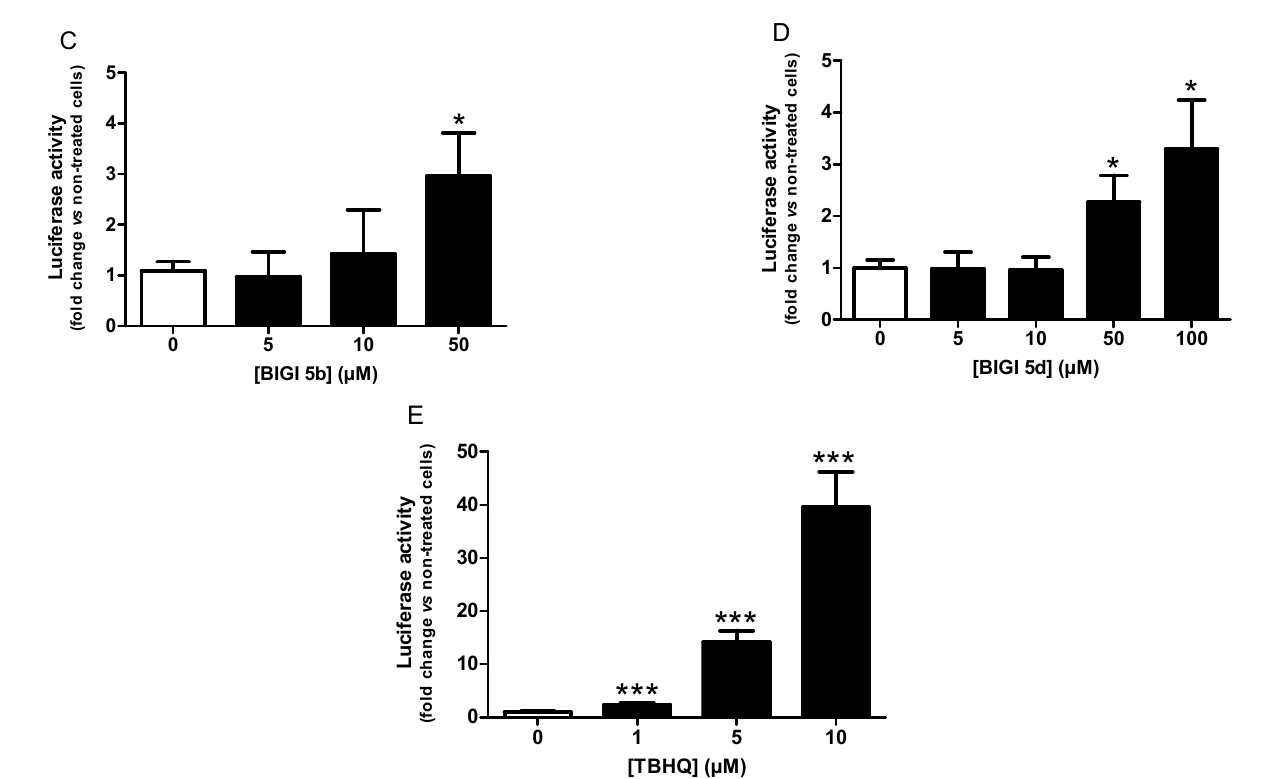
Figure 2. Nrf2 transcriptional activation potencies of compounds BIGI 4b ( A ), BIGI 4d ( B ), BIGI 5b ( C ), and BIGI 5d ( D ) or reference compound TBHQ I ( E ). Data are means ± SEM of at least 3 different experiments. * p ≤ 0.05 and *** p ≤ 0.001 with respect to non-treated cells (control cells). CD values (i.e., the concentration required to double the specific activity of the lu- ciferase reporter) were calculated to compare the relative potencies. As shown in Table 2, compounds BIGI 4b , BIGI 4d , and BIGI 5b were the most potent with a CD value equal to 7.1, 7.7, and 13.5 µ M, respectively, compared with TBHQ which showed 0.8 µ M. These compounds are thus only 9- to 17-fold less active than TBHQ, one of the most potent activators of Nrf2. Compound 5d also showed an interesting CD value equal to 33.4 µ M and was therefore 42 times less active than TBHQ but, for example, 2 times more active than melatonin (CD = 60 µ M) [32] which is able to induce transcriptional pathway through several mechanisms [33]. Table 2. Nrf2 induction potencies of compounds BIGI 4b , BIGI 4d , BIGI 5b , and BIGI 5d and reference compound TBHQ in Nrf2/ARE-luciferase reporter cells.